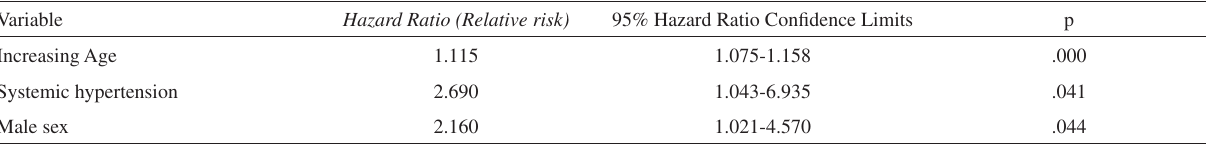
Table V - Risk factors associated with an IMT greater than